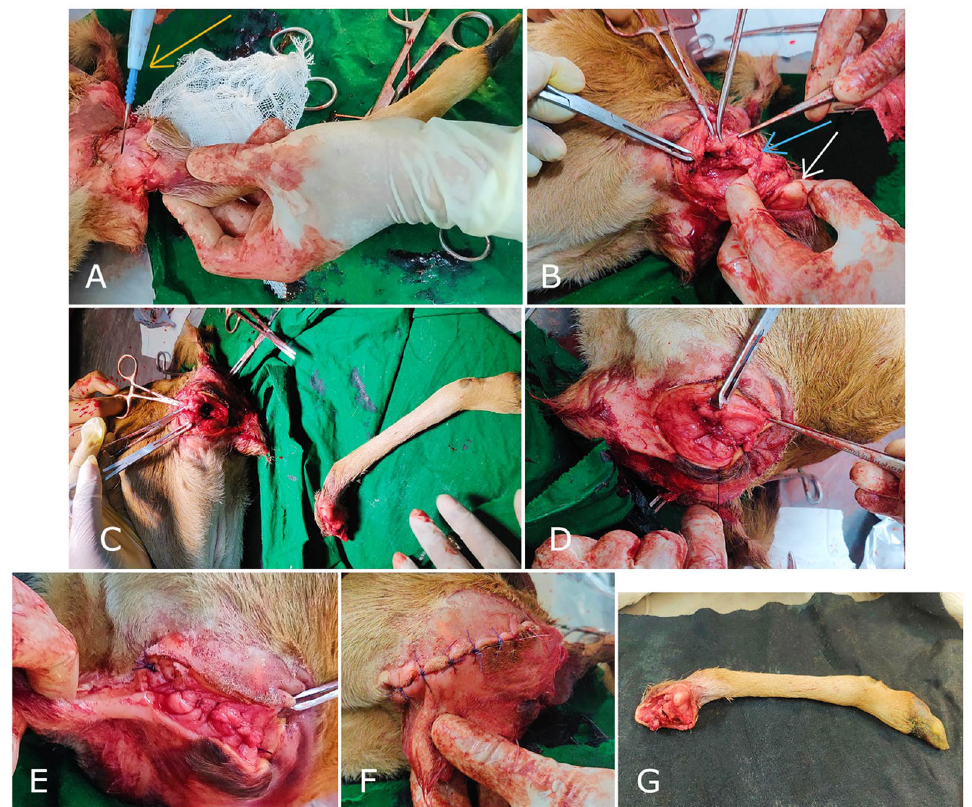
Fig. 3 Different phases of electrosurgery to excise the fifth additional limb along with the final wound closure. A Monopolar electro-probe (yellow arrow) having simultaneous cutting and coagulation capacities applied locally for the transection of the limb. B Exposure of the femur-head like bony prominence (white arrow) detached from thin cartilages (blue arrow) and fibrous connective tissues adjacent to the structure. C A muscular hollow in the gluteal region derived from the surgical removal of the limb. D Closure of the hollow cavity by purse string suture. E Closure of the surrounding muscles by simple continuous suture. F Skin closure by simple interrupted sutures. G The discarded